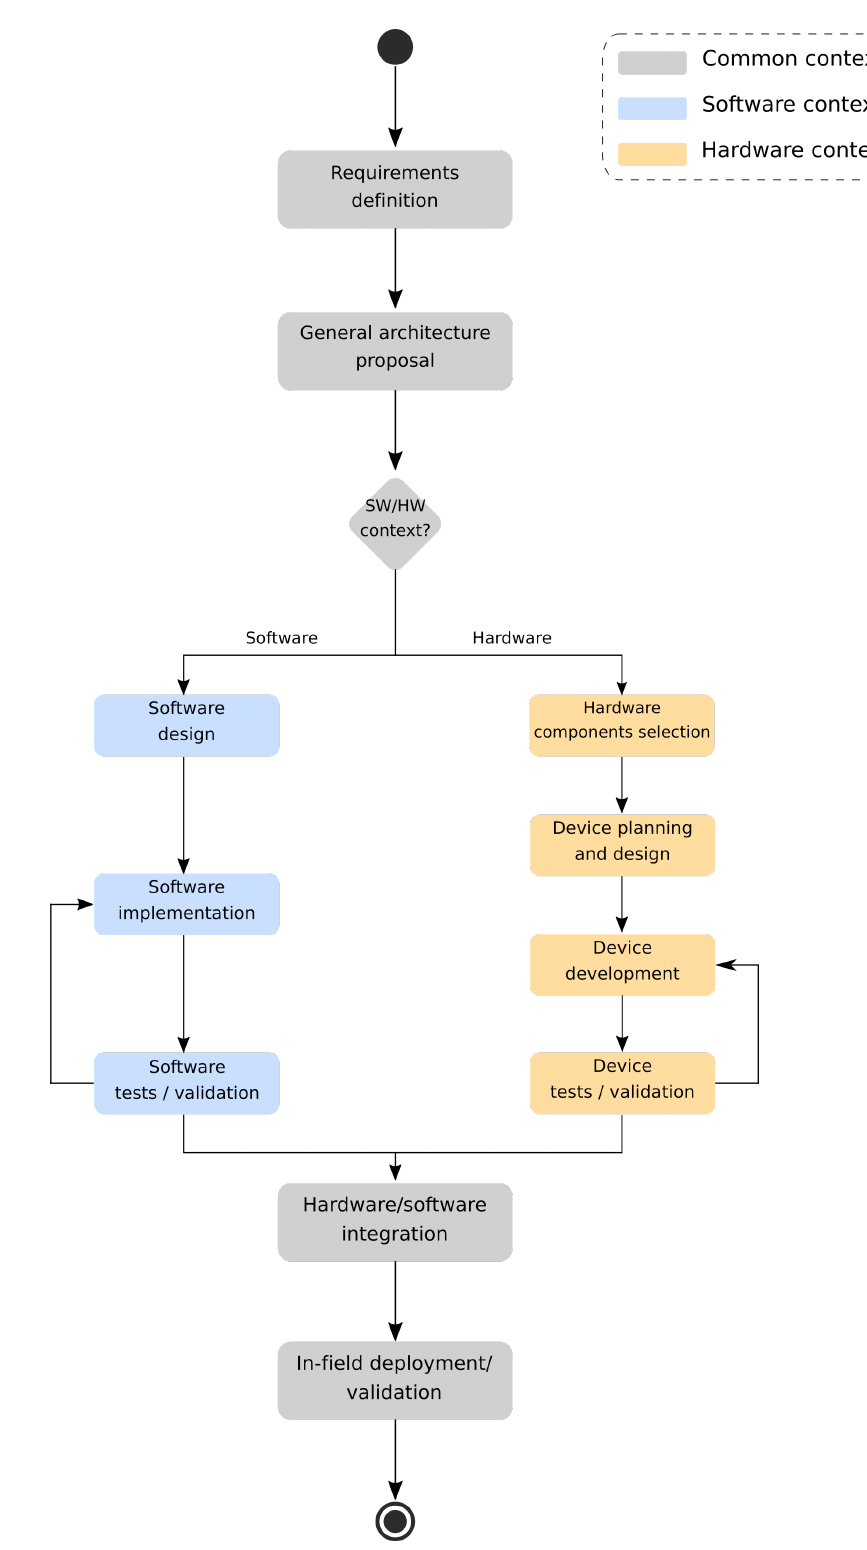
Figure 1. Diagram outlining the steps taken into consideration when designing a new wearable